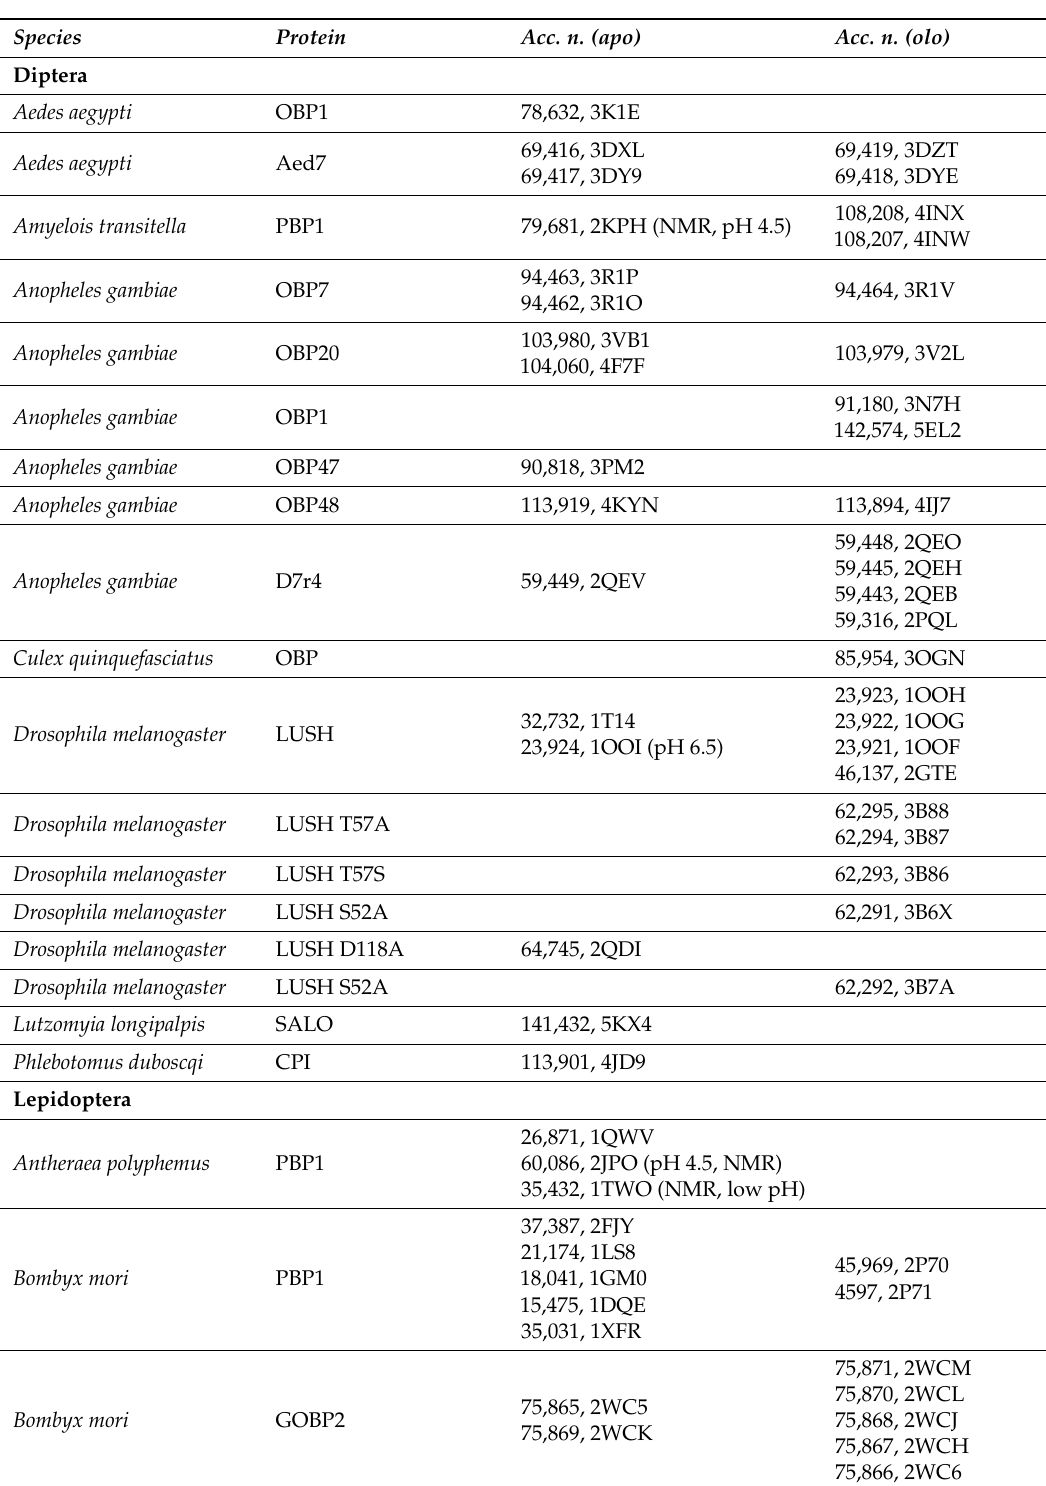
Table 2. Structures of insect OBPs. Accession numbers are: MMDB;